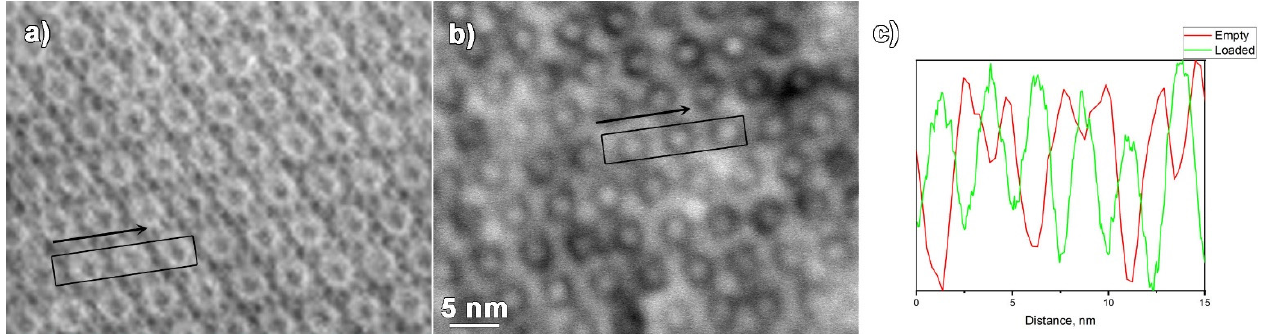
Figure 3. ADF-STEM images of the ( a ) MIL-101 particle and ( b ) Ru@MIL-101 particle, both taken along the [011] zone axis of MIL-101, black boxes and arrows mark the location and direction of the intensity line profiles. ( c ) Intensity line profiles shown in green for the Ru@MIL-101 and red for the MIL-101.